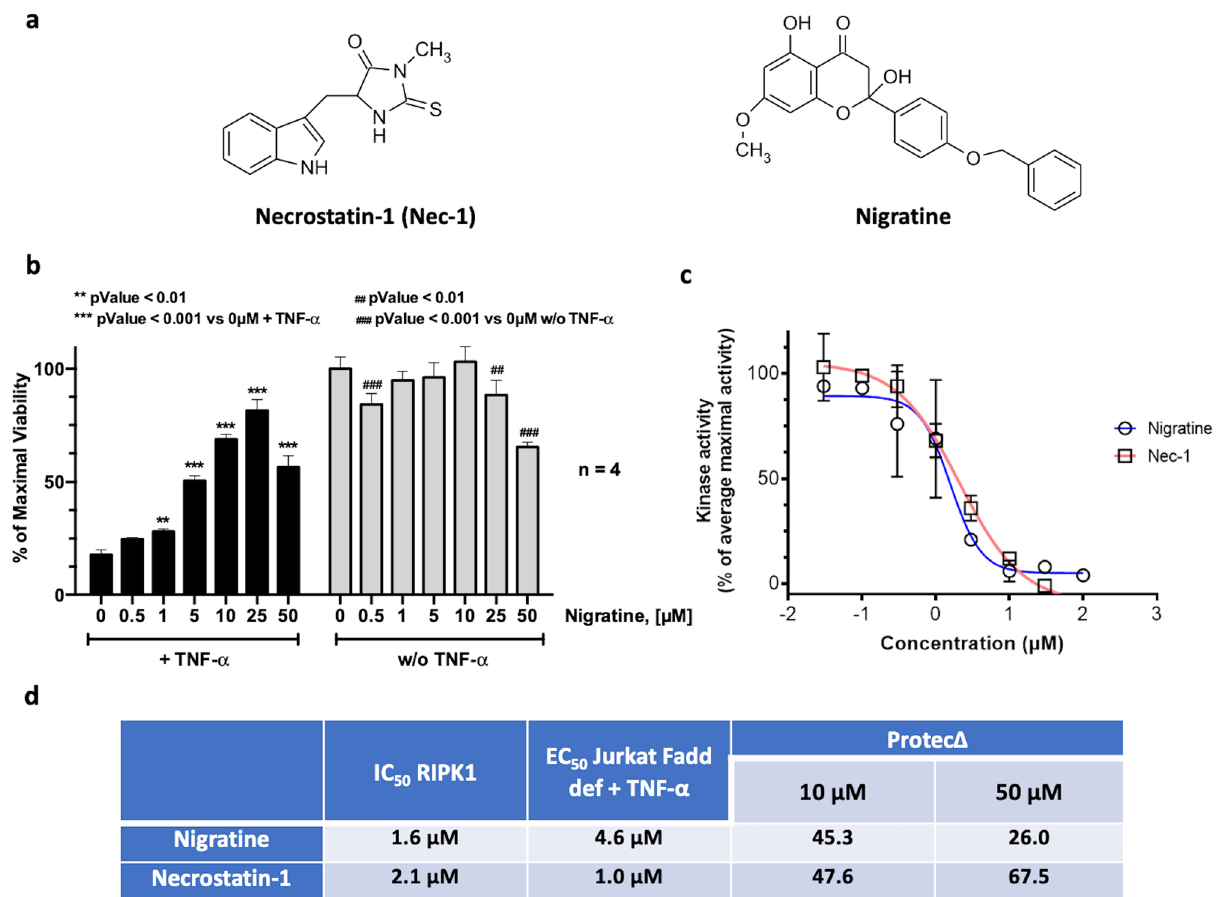
Figure 1. Nigratine inhibits necroptosis by targeting RIPK1 kinase. ( a ) Nigratine and necrostatin-1 (Nec-1), as control inhibitor of necroptosis, are structurally non related molecules. ( b ) Jurkat-Fadd def cells were treated 24 h with increasing concentrations of nigratine alone or co-treated with 10 ng/ml of TNF-α. Cell viability was estimated by MTS assay. Data are shown as the mean ± SD of four replicates. ( c ) The RIPK1 catalytic activity was monitored using myelin basic protein, MBP, as a substrate. RIPK1 was assayed in the presence of increasing concentrations of both nigratine and Nec-1. The kinase activities are expressed in % of average maximal activity, i.e. measured in the presence of DMSO (n = 2, mean ± SEM). ( d ) The IC 50 (on kinase) and EC 50 and “protection delta” (ProtecΔ) (on cells) values were determined from the dose–response curves using Graphpad PRISM software and reported in the table. The level of protection against the TNF-α-induced cell death is estimated using the ProtecΔ values (first described and used in 16 ). These data are determined by subtracting the value obtained for cells only treated with TNF-α from the value obtained for co-treatment with TNF-α and with the tested